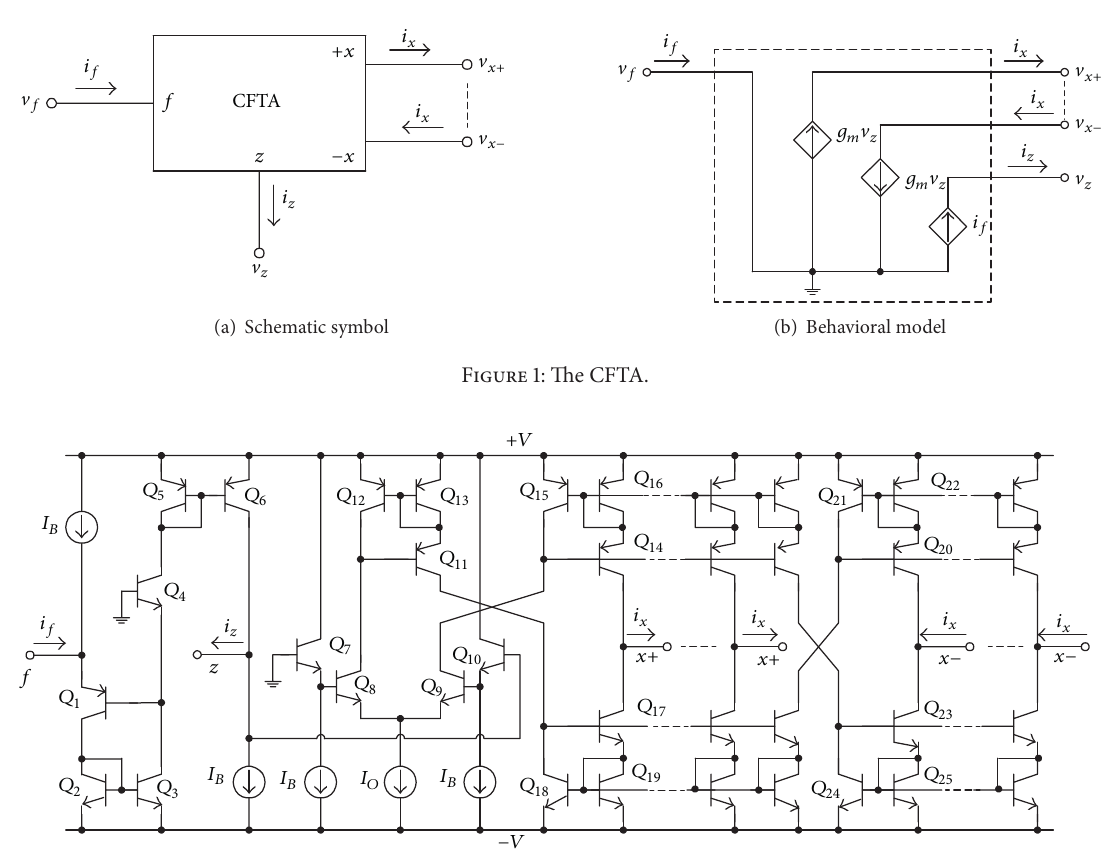
Figure 2: Implementation of the